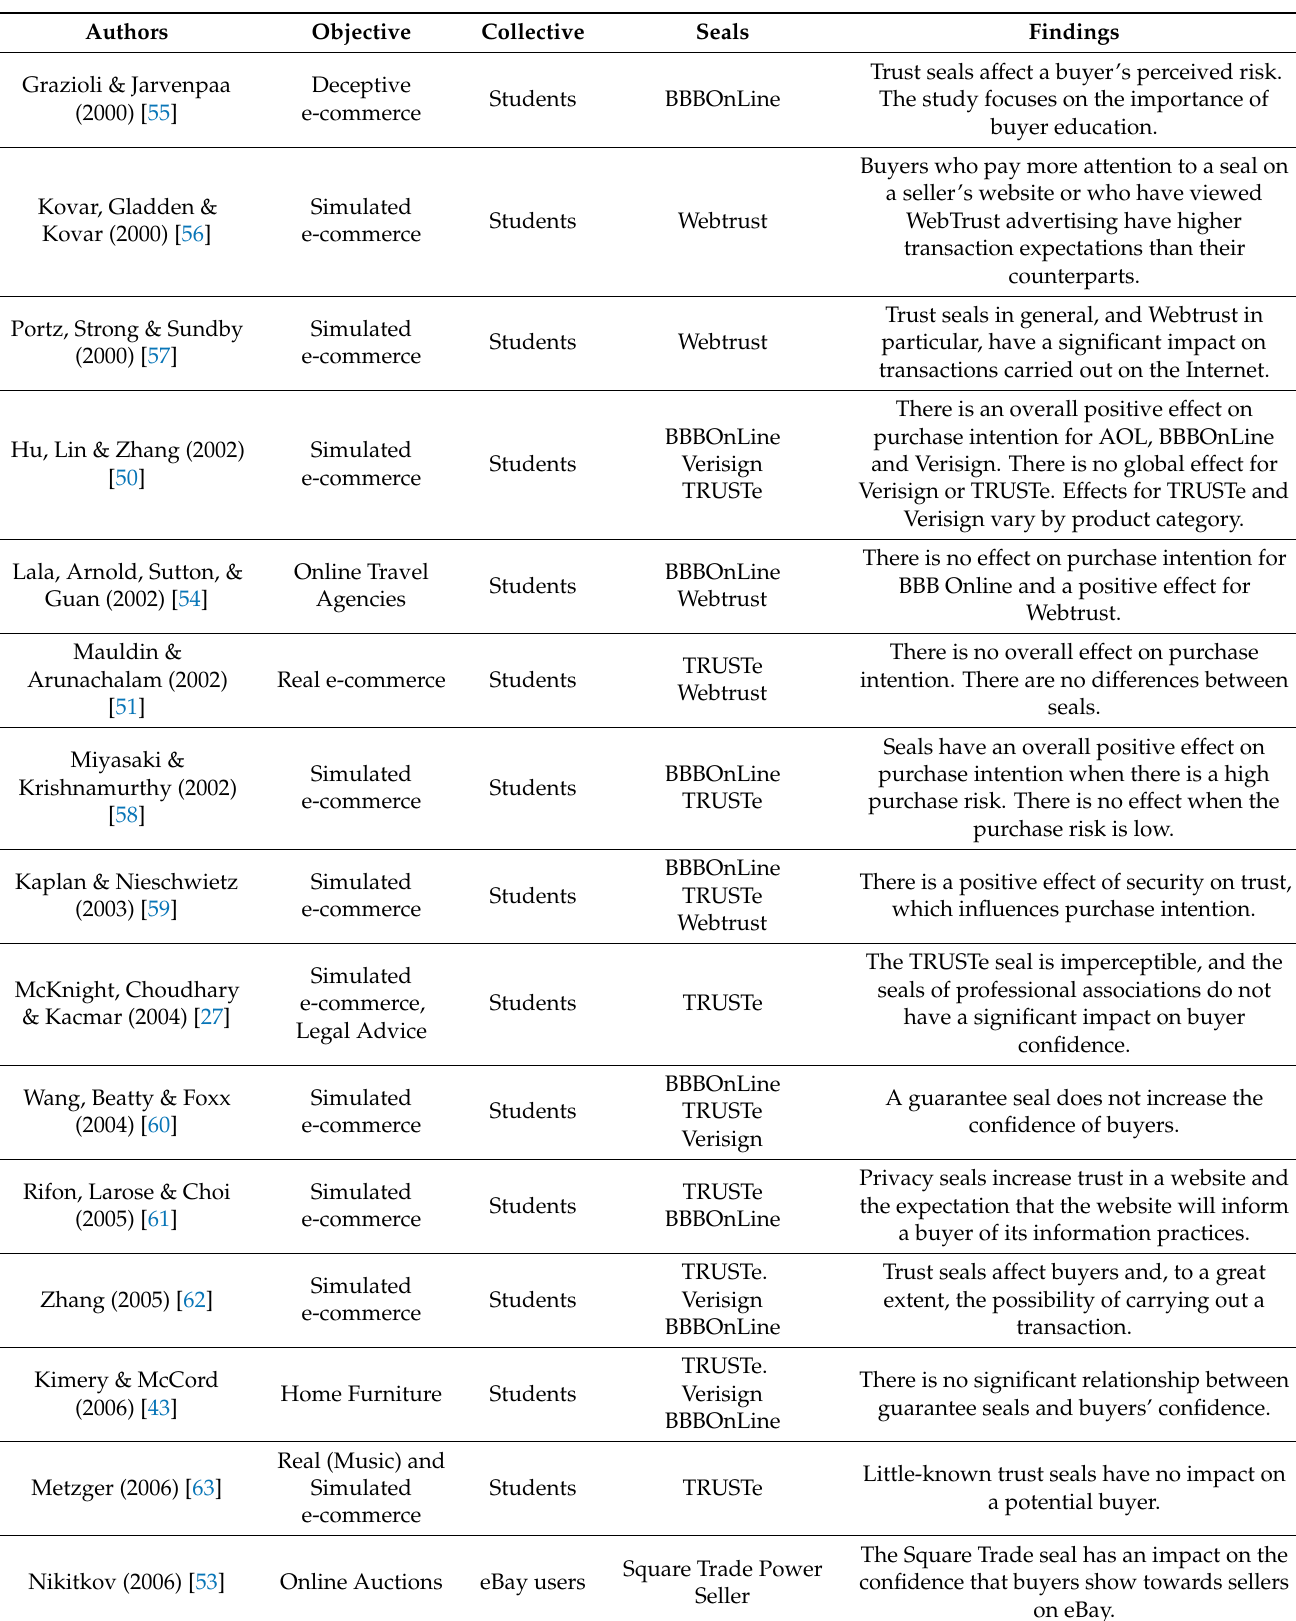
Table 1. Summary of a Sample of Empirical